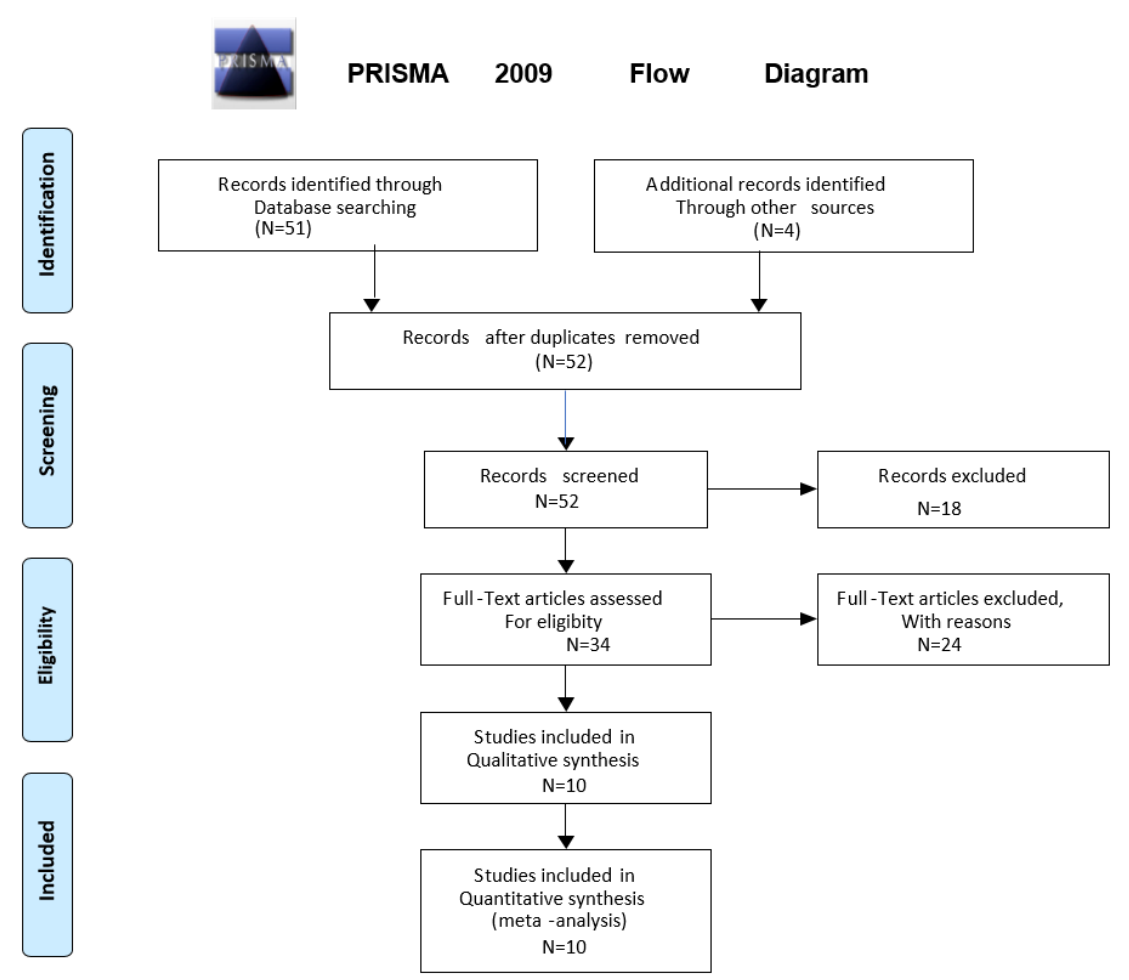
Figure 1: Ooutline of the search strategy using the PRISMA format